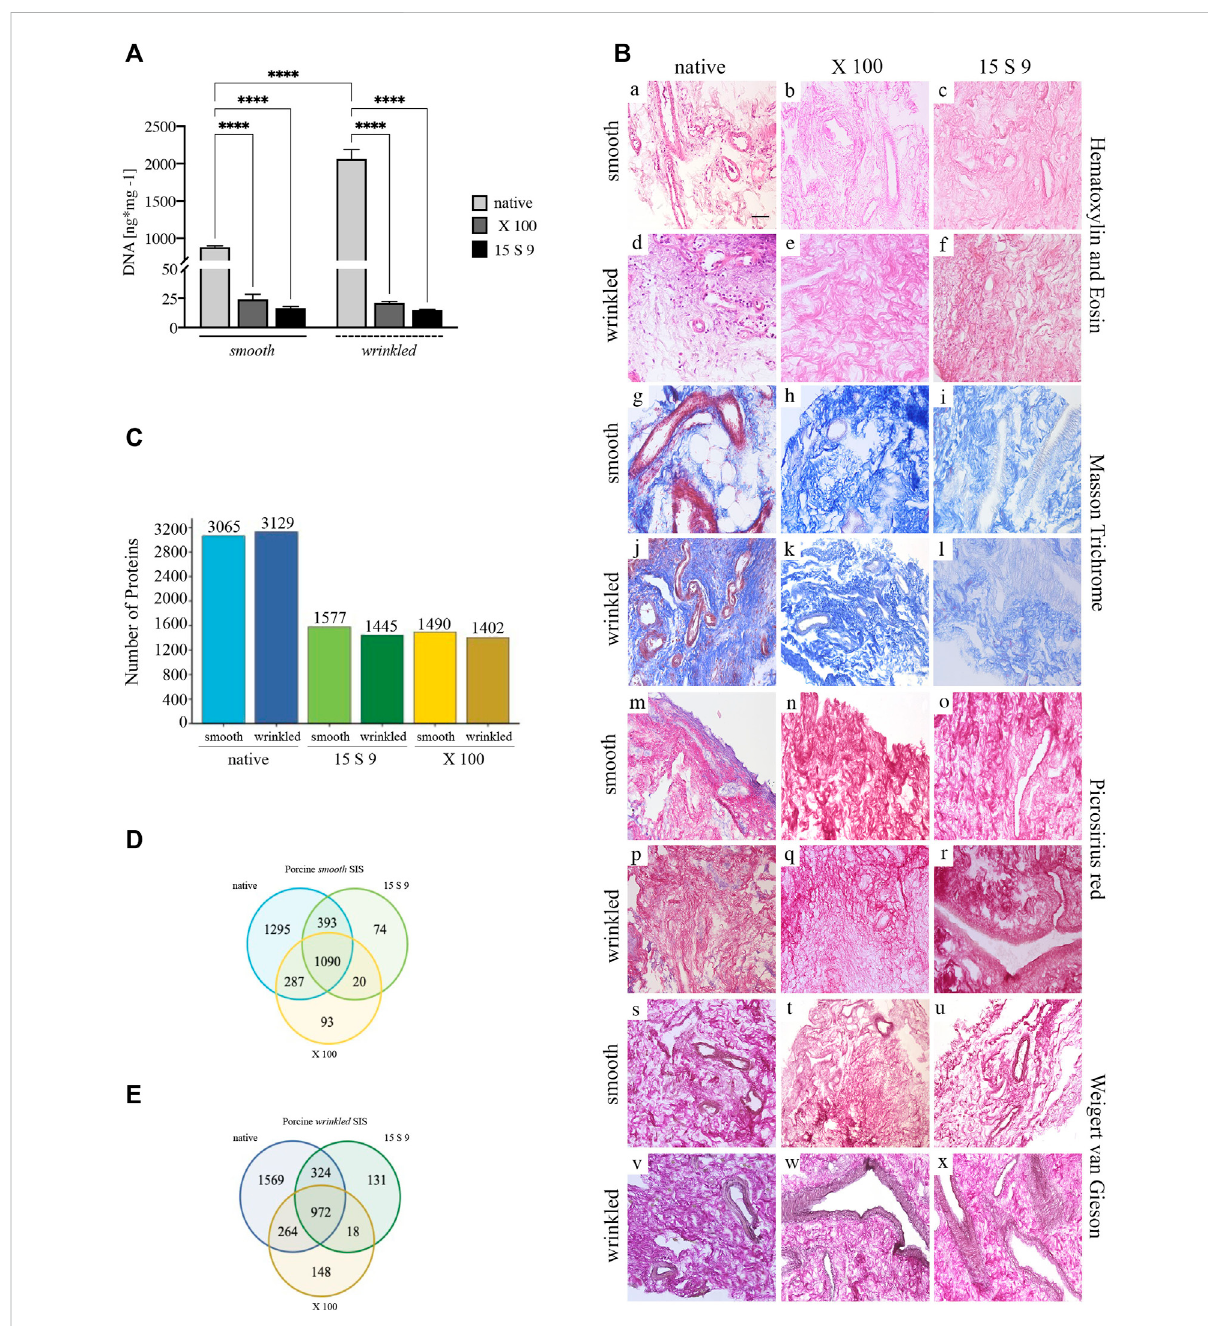
FIGURE 2 YieldandpreservationofSIStissuebeforeandafterdecellularizationwithX100and15 S9. (A) DNAquanti fi cation.TheamountofDNA( n =6for each) was signi fi cantly reduced, compared to the native, in the smooth and wrinkled portion after X 100 and 15 S 9 ( p- value < 0.0001), although the number of initial cells in the native wrinkled was signi fi cantly higher than in the native smooth ( p- value < 0.0001). (B) . Hematoxylin and eosin (a – f). A retainedECMwaspresentafterbothdecellularizations(inpink).Incontrasttothenativeparts(smooth,a;wrinkled,d),thenuclei(inpurple)were completely absent in the decellularized tissues (smooth b, c and wrinkled e, f: X 100 and 15 S 9, respectively). Masson ’ s trichrome (g – l). The organization and preservation of collagen fi bers (in blue) together with the vascular apparatus (in red) were maintained after both decellularizations (smooth h, i and wrinkled k, l: X 100 and 15 S 9, respectively). Nuclei (in black brown) were absent in the decellularized, compared to the native (smooth, g; wrinkled, j). Picrosirius red (m – r). The morphology of the collagen network and vessels (in red) was preserved after decellularization (smoothn,oandwrinkledq,r:X100and15 S9,respectively)comparedtothenatives(smooth m;wrinkledp).Weigert-VanGieson(s – x).Nochange incollagen fi bers(inred)andelastic fi bersaroundthevesselsmainly(inblack)ofthedecellularizedECM(smootht,uandwrinkledw,x:X100and15 S 9, respectively) compared to the native (smooth s; wrinkled, v). (C) Full Proteome analysis. A higher amount of protein content was present in the native wrinkled with respect to decellularized tissues. Venn diagrams of proteins regulated in (D) porcine smooth and (E) wrinkled compared to the native tissue. Scale bar: 100 um. Magni fi cation: